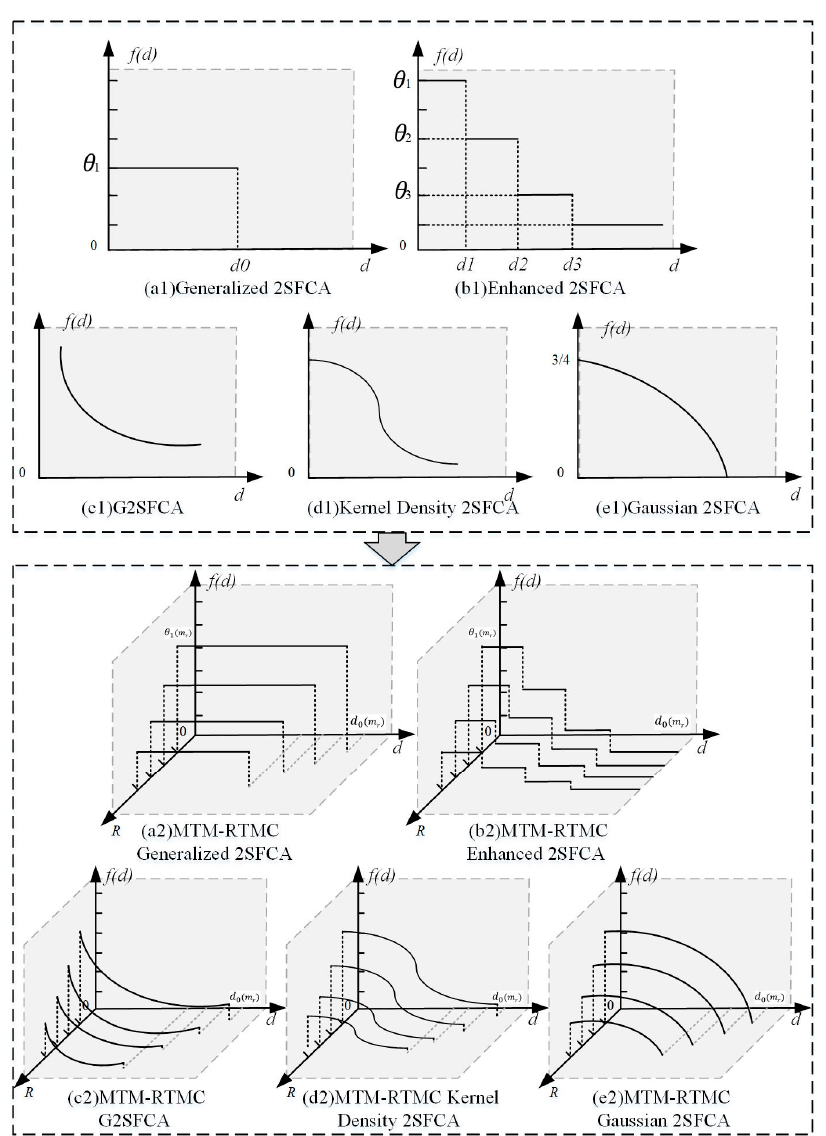
Figure 11. Di ff erent distance decay Figure 11. Different distance decay functions.